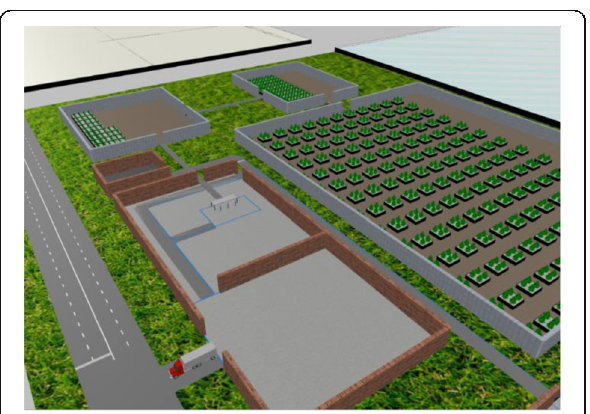
Fig. 11 (Abstract P9). 3D greenhouse production flow